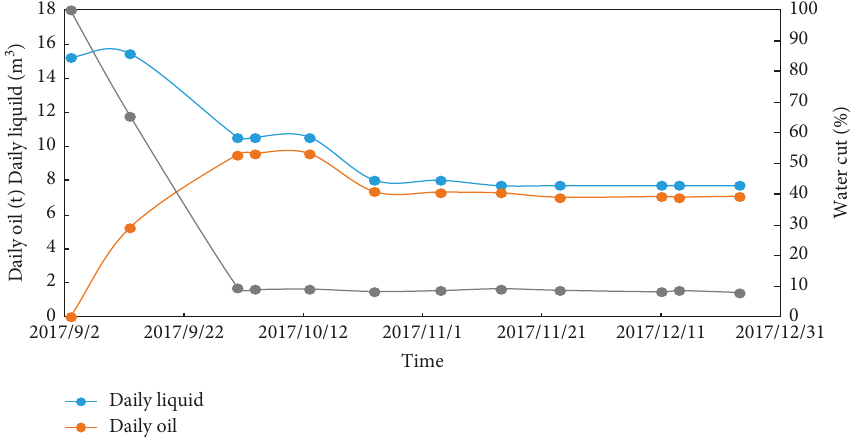
Figure 8: Production curve of A1 well.